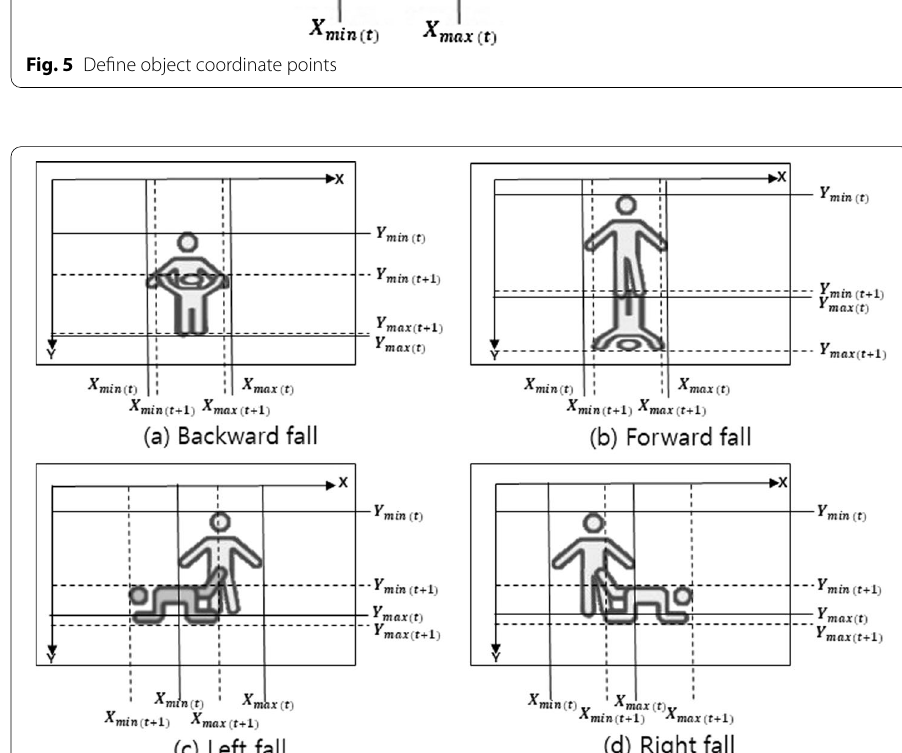
Fig. 6 Difference of object coordinates in fall